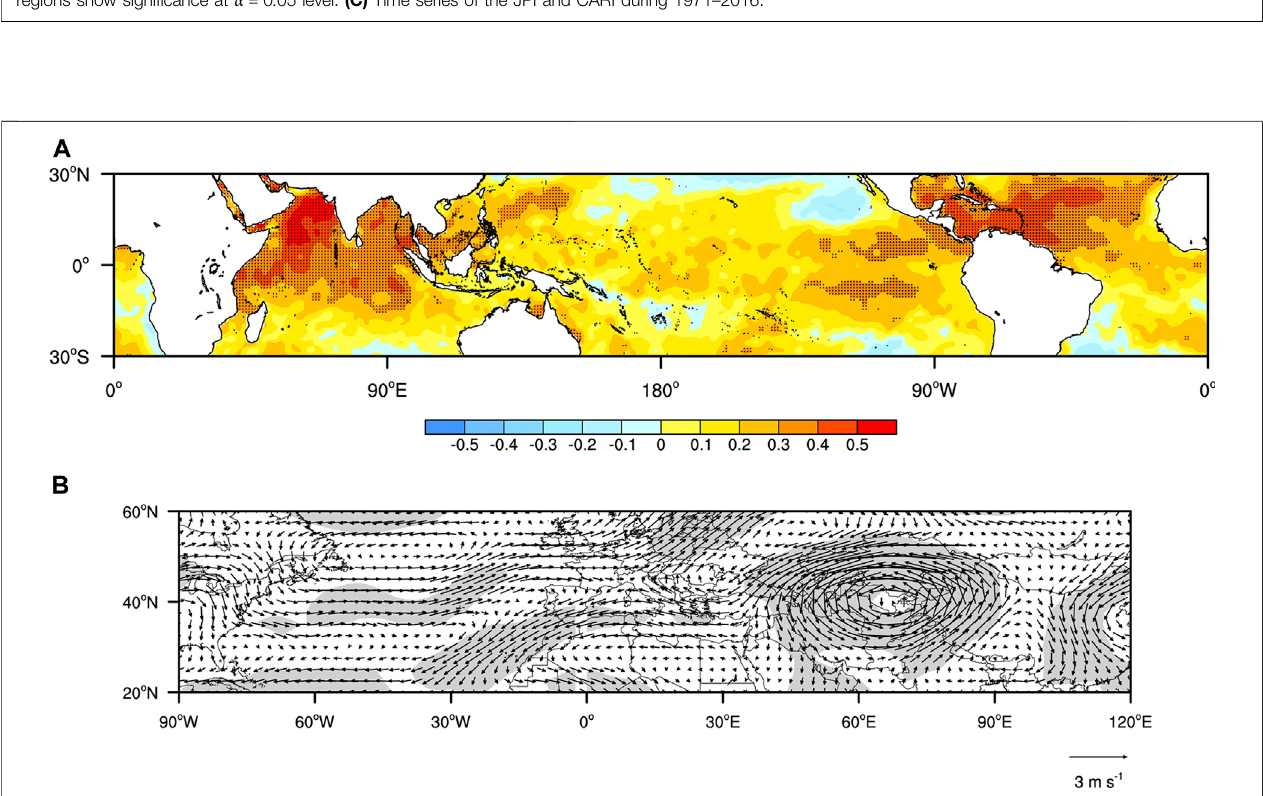
FIGURE10|(A) CorrelationoftheJPIand SSTsinthetropical oceans,dotted regionsshowsigni fi canceat α (cid:2) 0 . 05level. (B) Regressionof200 hPawind against the regional mean SSTs over the domain 10 – 30 ° N, 90 – 30 ° W during 1971 – 2016, shaded regions show signi fi cance at α (cid:2) 0 . 05 level.